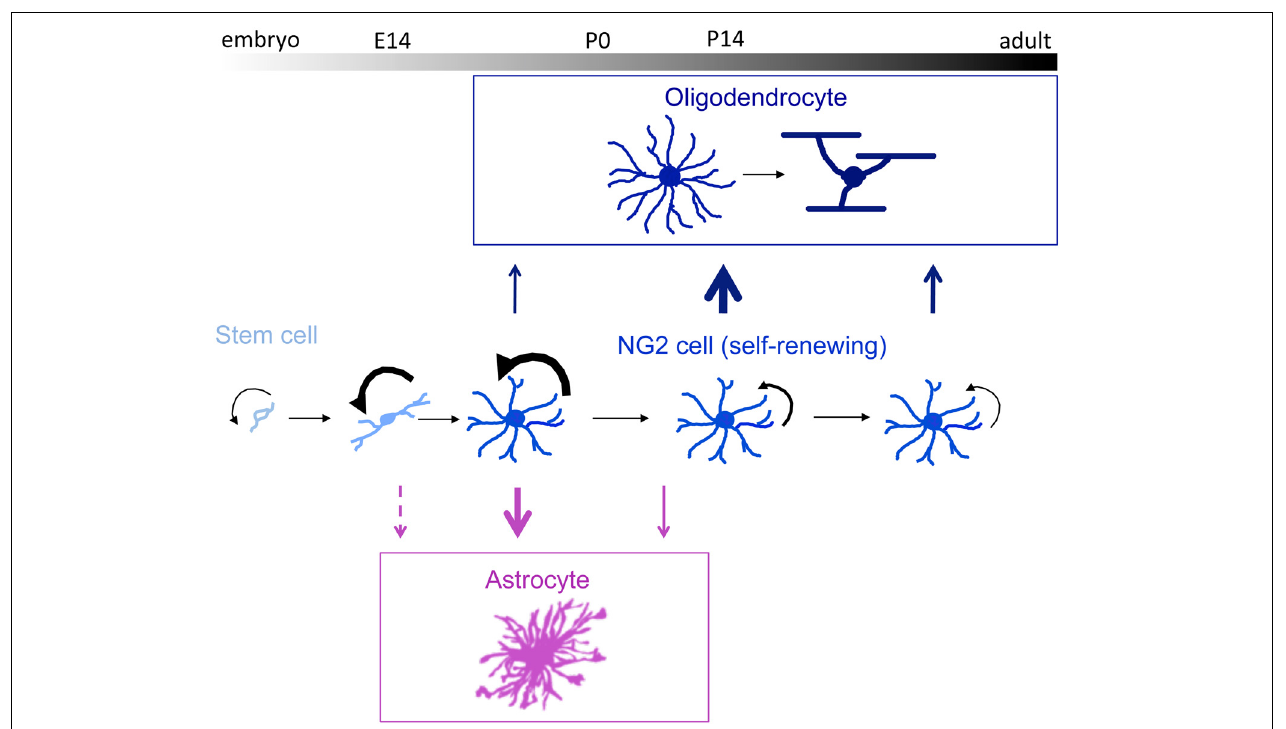
FIGURE 1 | A schematic showing the fate of NG2 cells throughout development. The middle diagram depicts self-renewing NG2 cells, with a chronological scale across the top. Black arrows indicate the rate of proliferation, which is greatest perinatally. Blue upward arrows indicate oligodendrocyte differentiation, peaking during